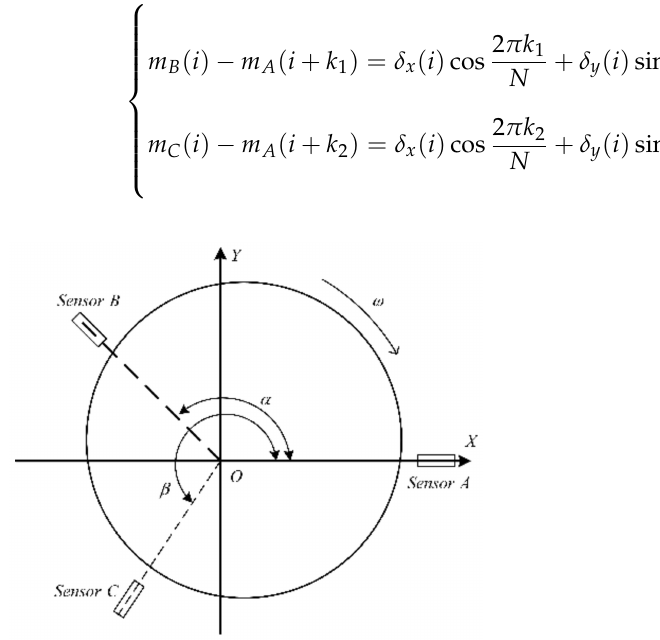
Figure 4. Schematic view of the three-probe error separation